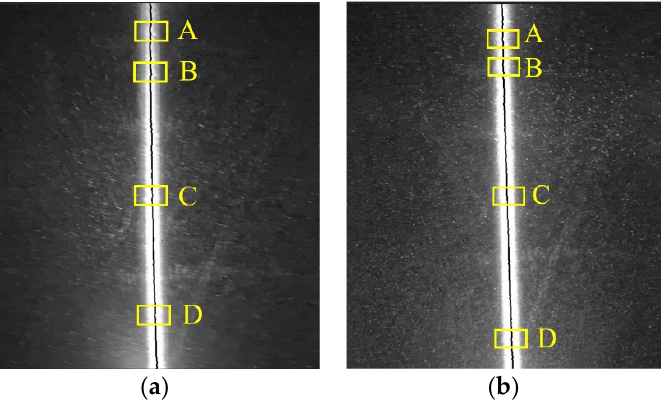
Figure 10. Comparison of local waggle areas. ( a ) The proposed method. ( b ) The standard method.